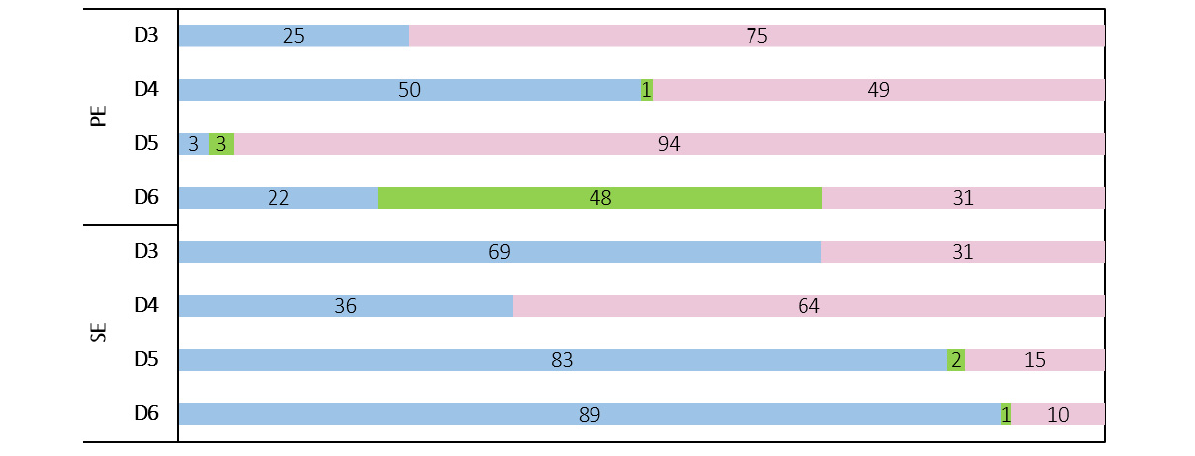
Figure 11. Mass distribution (%) of D3, D4, D5 and D6 between the first (t 0 ) and last (t f ) days of the PE and SE assays.